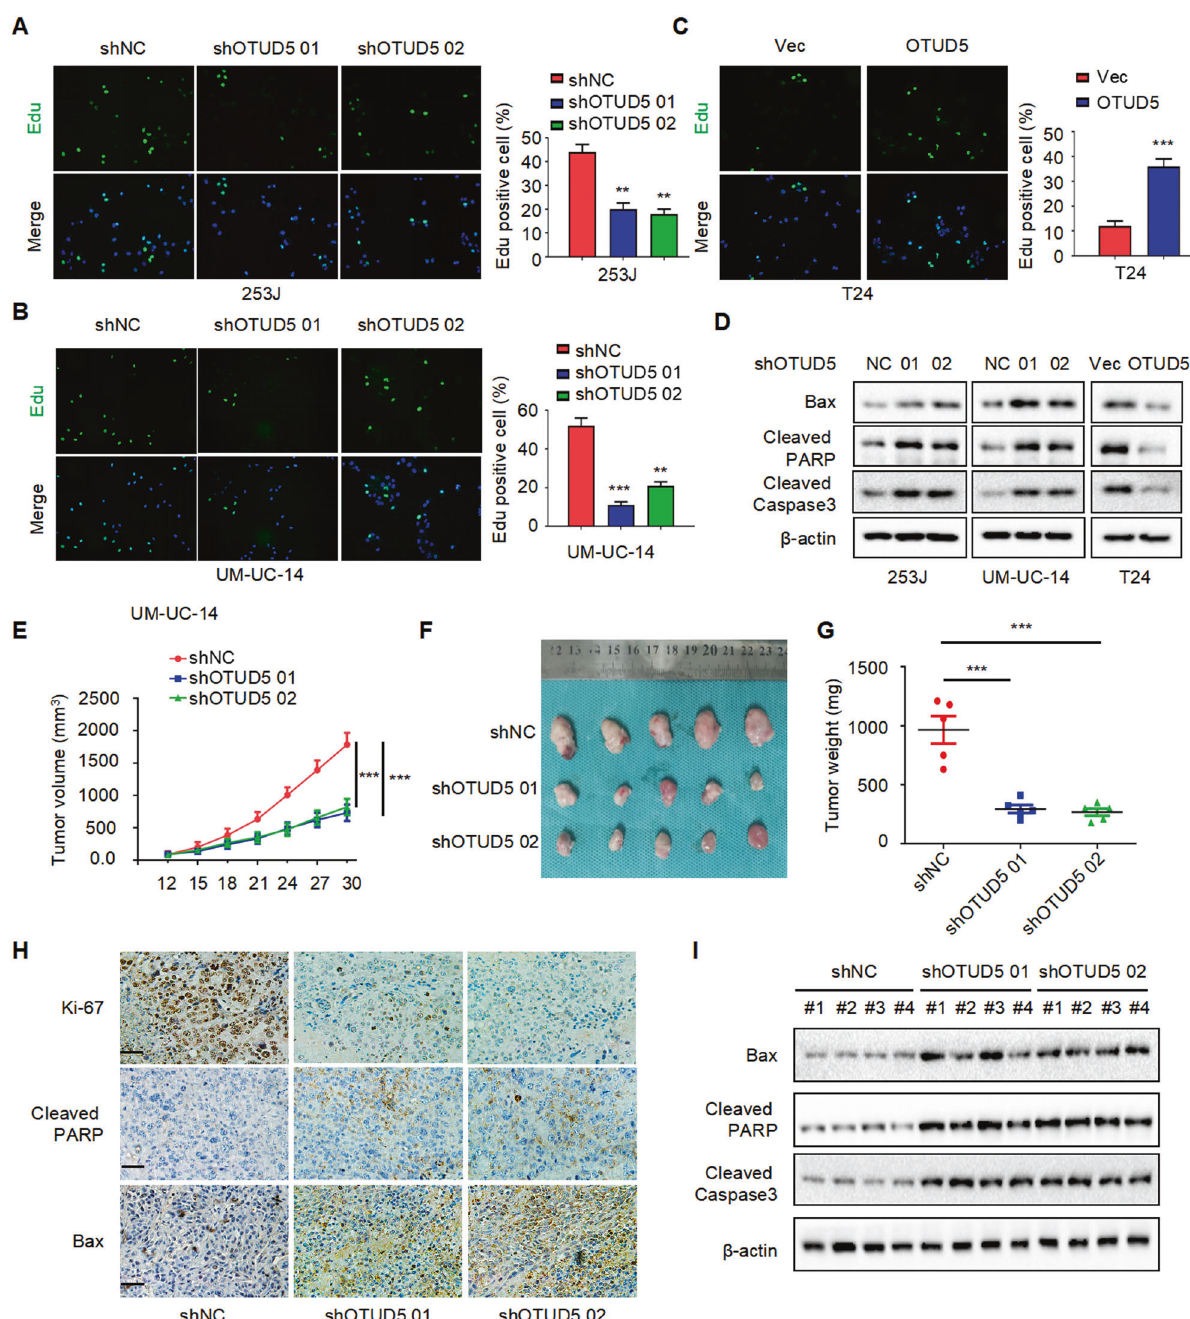
Fig. 2 OTUD5 promotes proliferation in bladder cancer. A , B , C EdU assay was performed to detect proliferation in 253 J and UM-UC-14 cells with OTUD5 knockdown and T24 cells with OTUD5 overexpression. ** P < 0.01, *** P < 0.001. D Western blot was performed to determine the effect of OTUD5 on the expression of apoptosis markers (Bax, Cleaved-PARP, Cleaved-Caspase3) in bladder cancer cells. All data are presented as mean ± SD of three independent experiments. E The growth curves of xenografts in different groups. Tumor volumes were measured every three days from day 12 to day 30. *** P < 0.001. F Illustration of tumors excised from male nude mice in each group. G After 30 days, the nude mice were sacri fi ced, and UM-UC-14 cell xenografts were weighed. *** P < 0.001. H Immunohistochemical analysis of Ki67, Bax and Cleaved- PARP in tumor xenografts. I Western blot analysis of Bax, Cleaved-PARP and Cleaved-Caspase3 expression in tumor we examined the tumor tissues by Western blot (Fig. 6F) and immunohistochemistry (Fig. 6G). The results showed that compared with the control group, the expression of p-mTOR and RNF186 were downregulated while the expression of sestrin2 was upregulated in the OTUD5 knockdown group. These results are consistent with the proposed OTUD5-RNF186-sestrin2-mTOR axis and suggest OTUD5 ’ s role in the regulation of the mTOR signaling pathway.